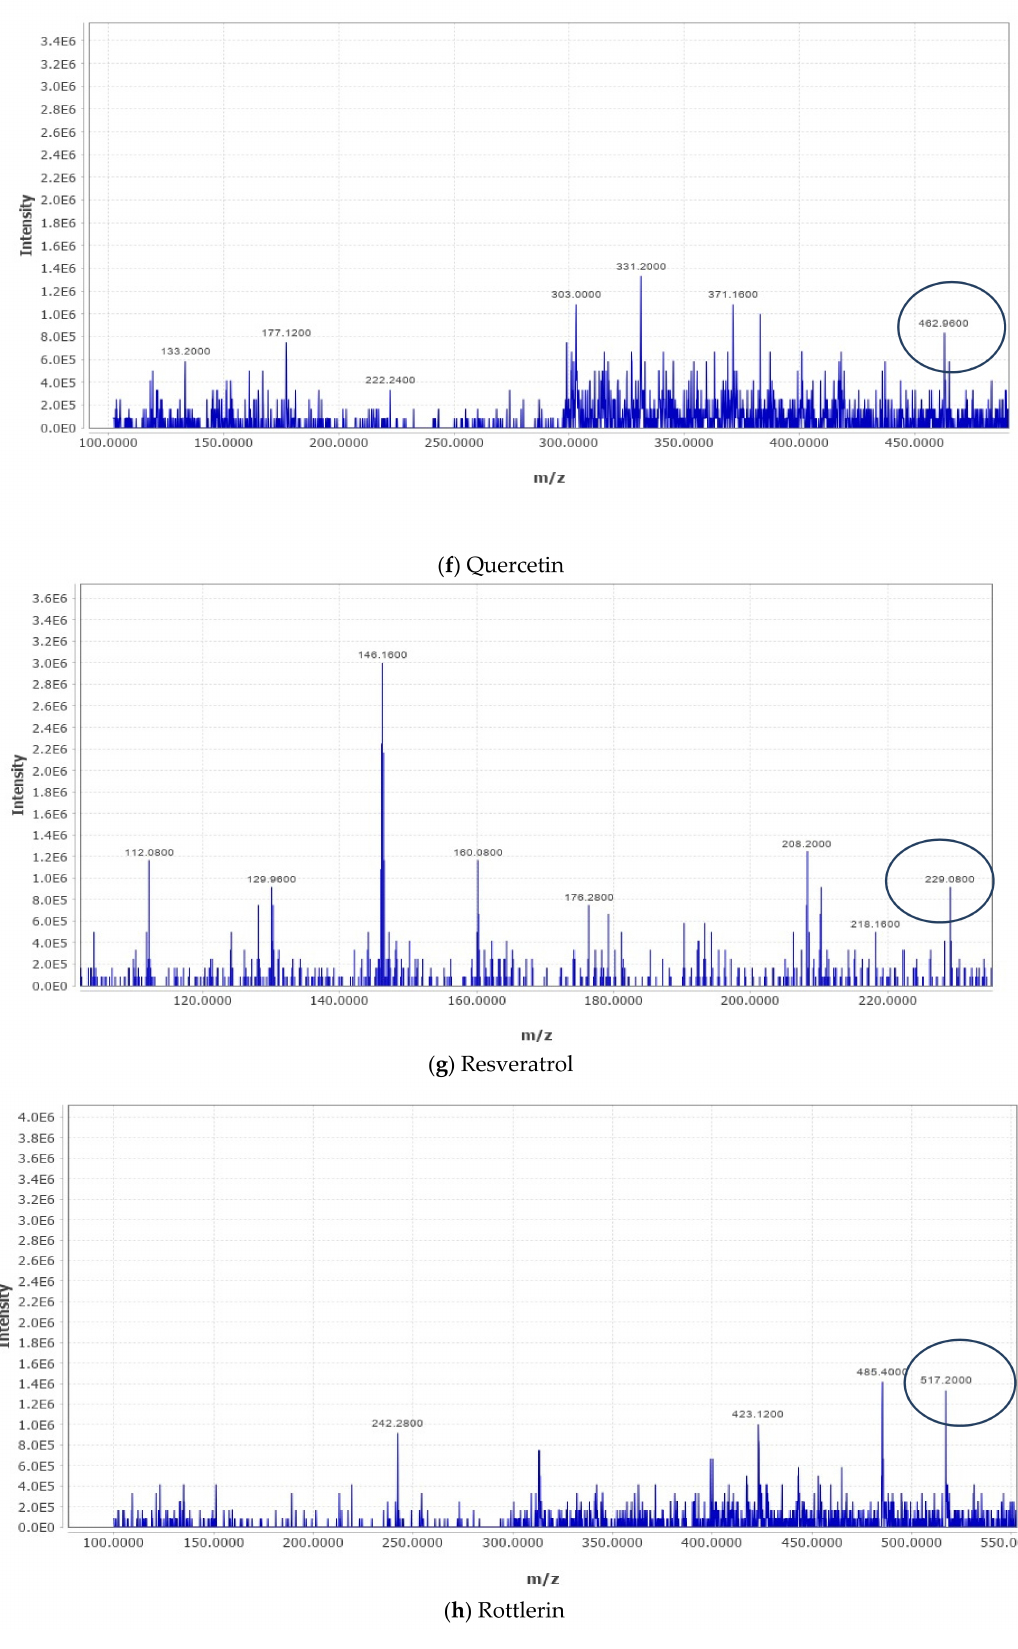
Figure 1. Chromatogram of key phytochemicals present in TA extract (this figure shows data from our recently published work